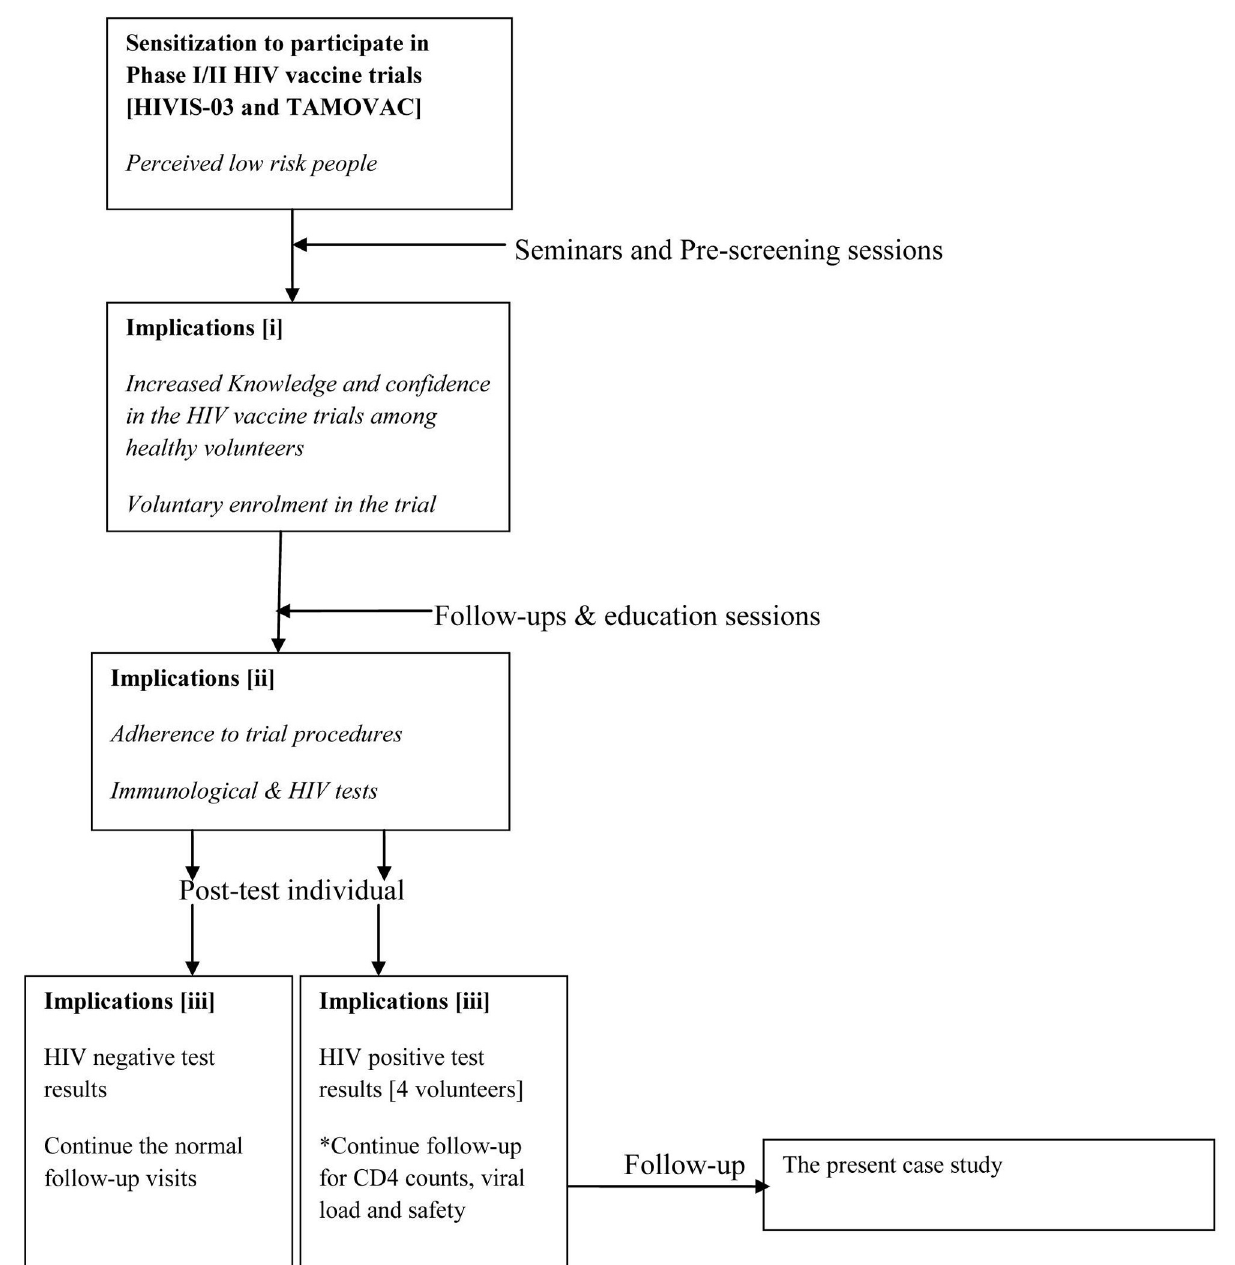
Fig 1. The participants’ journey in HIV vaccine